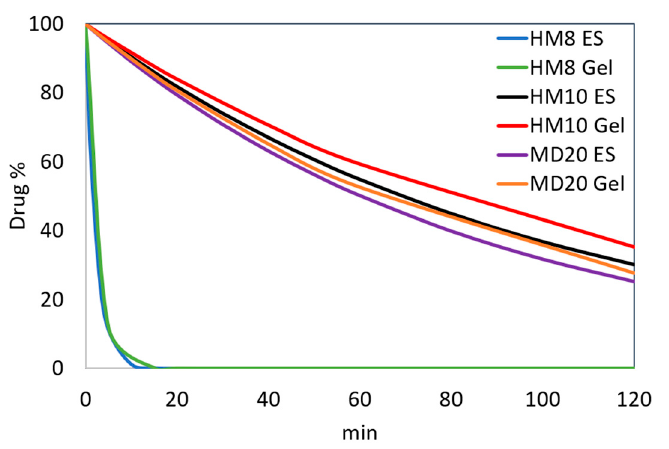
Figure 6. Comparison of the photodegradation profiles of HM8, HM10 and MD20 in ethanol and gel formulations.